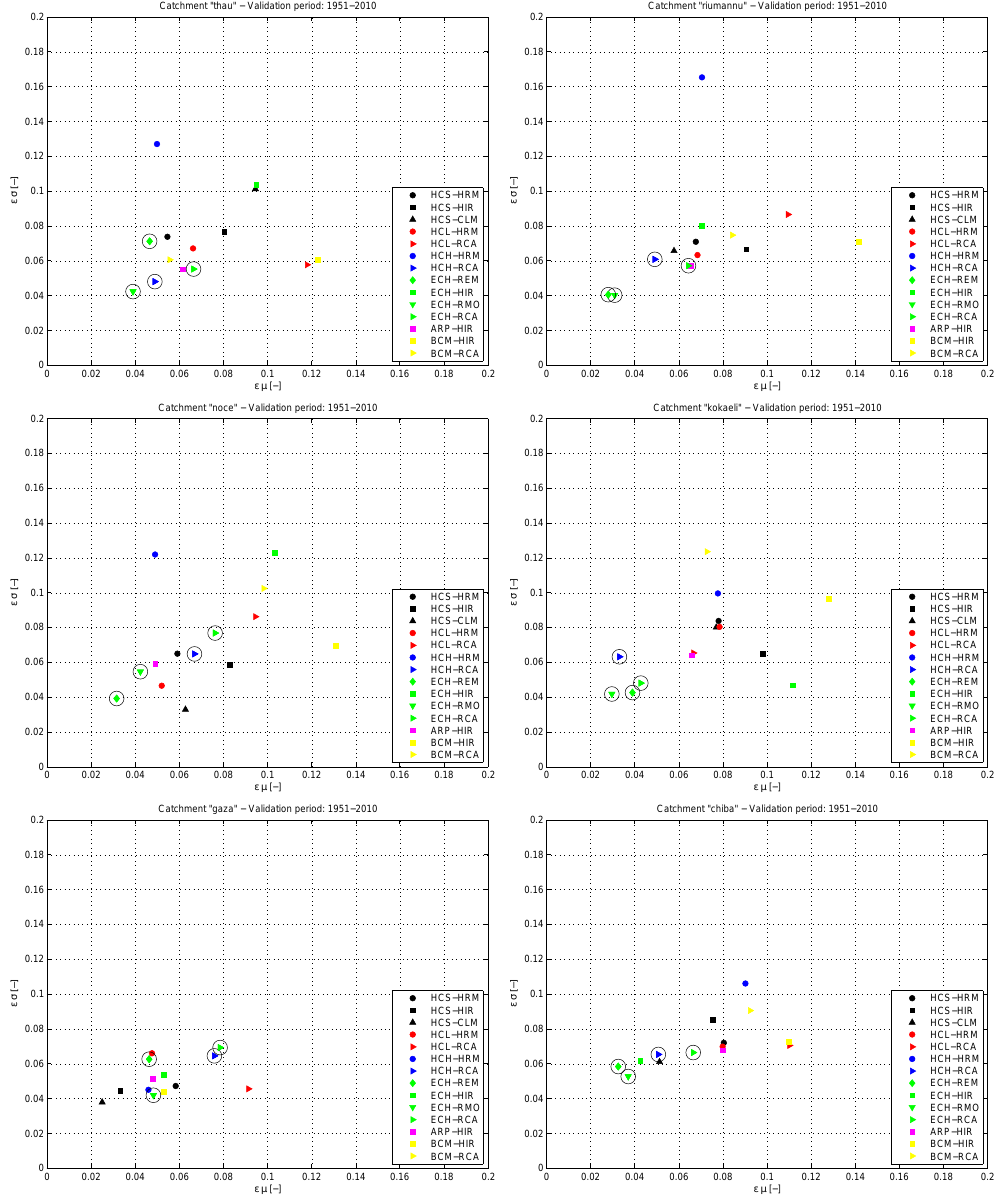
Fig.7. SameasFig.5, butforthedimensionlesserrormetricsaccountingforbothprecipitationandtemperature, Fig. 7. Same as Fig. 5, but for the dimensionless error metrics accounting for both precipitation and temperature, as defined in Eqs. (6) and (7). as defined in Eqs. (6) and (7). 1951 and 2100. In Fig. 9, where results for precipitation